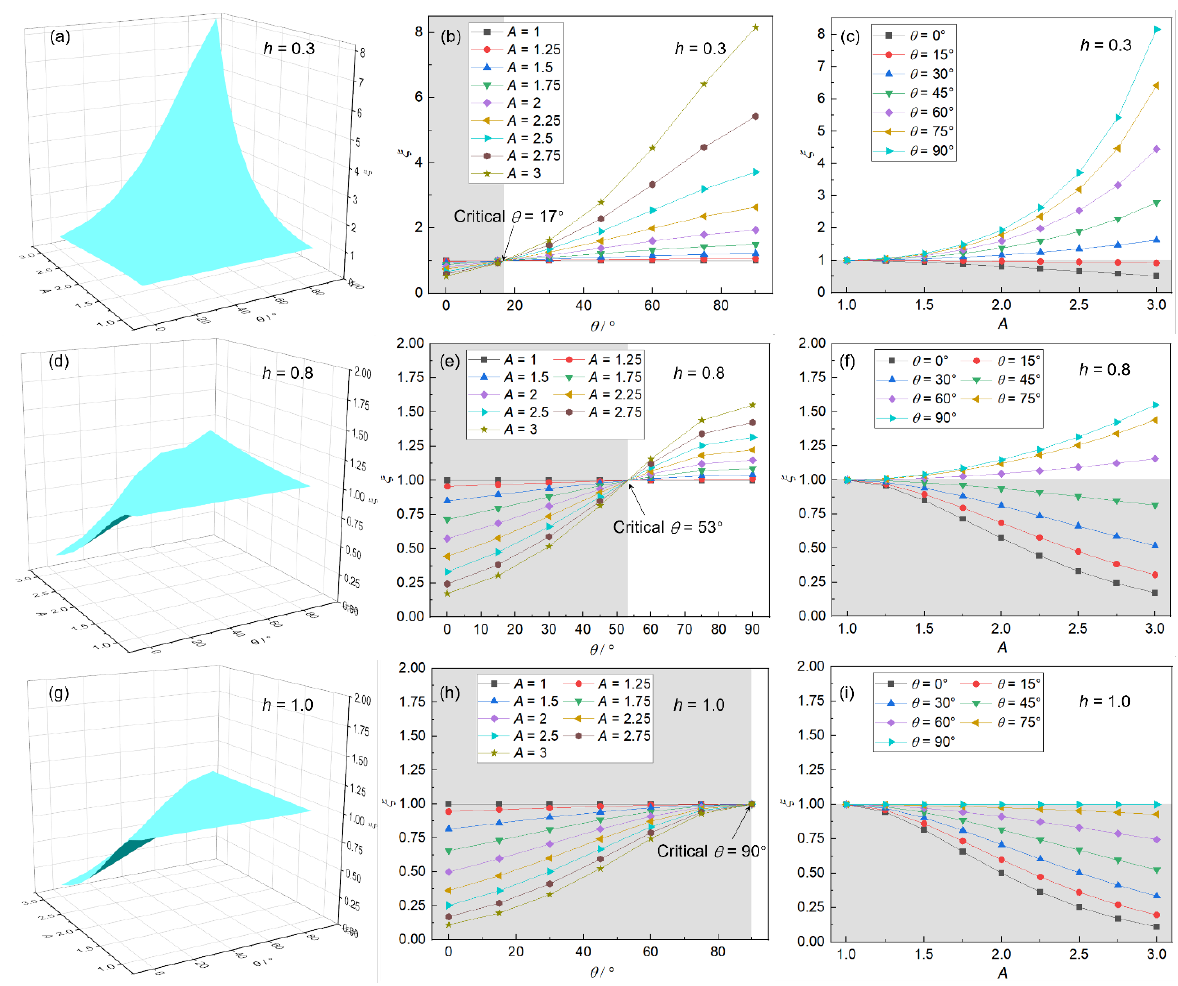
Figure 11. The variations R 2 of calibration results of Equation (16) with different values of h .